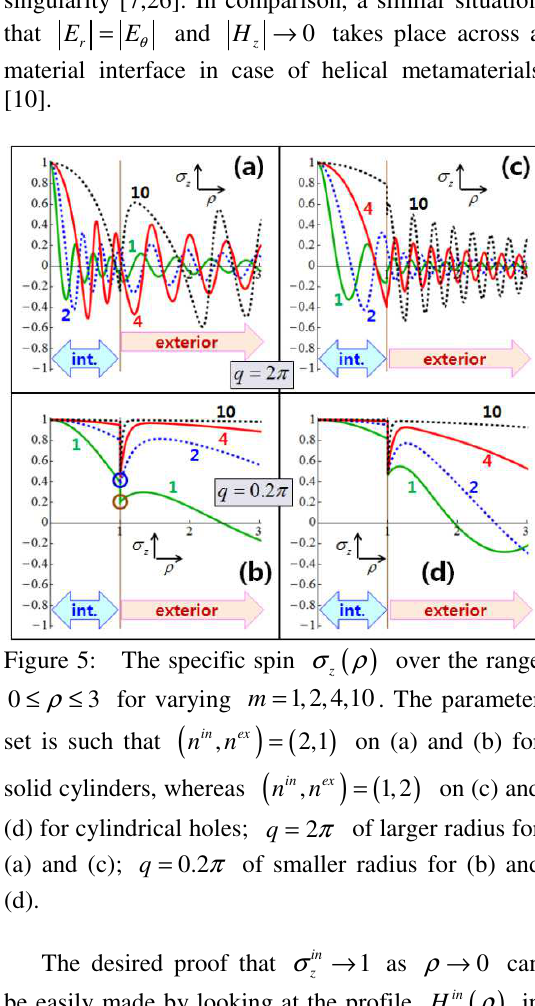
Figure 5: The specific spin ( ) 0 3 ρ ≤ ≤ for varying 1,2,4,10 m = . The